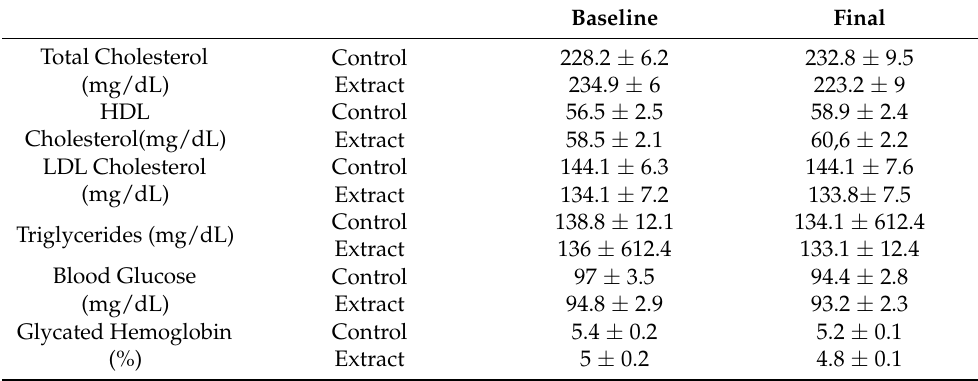
Figure 4. ( A ) Systolic blood pressure and ( B ) diastolic blood pressure determined by ABPM. Values are expressed by the increase (in mmHg) between the baseline and each control day. Table 2. The evolution of biochemical blood parameters of subjects during the